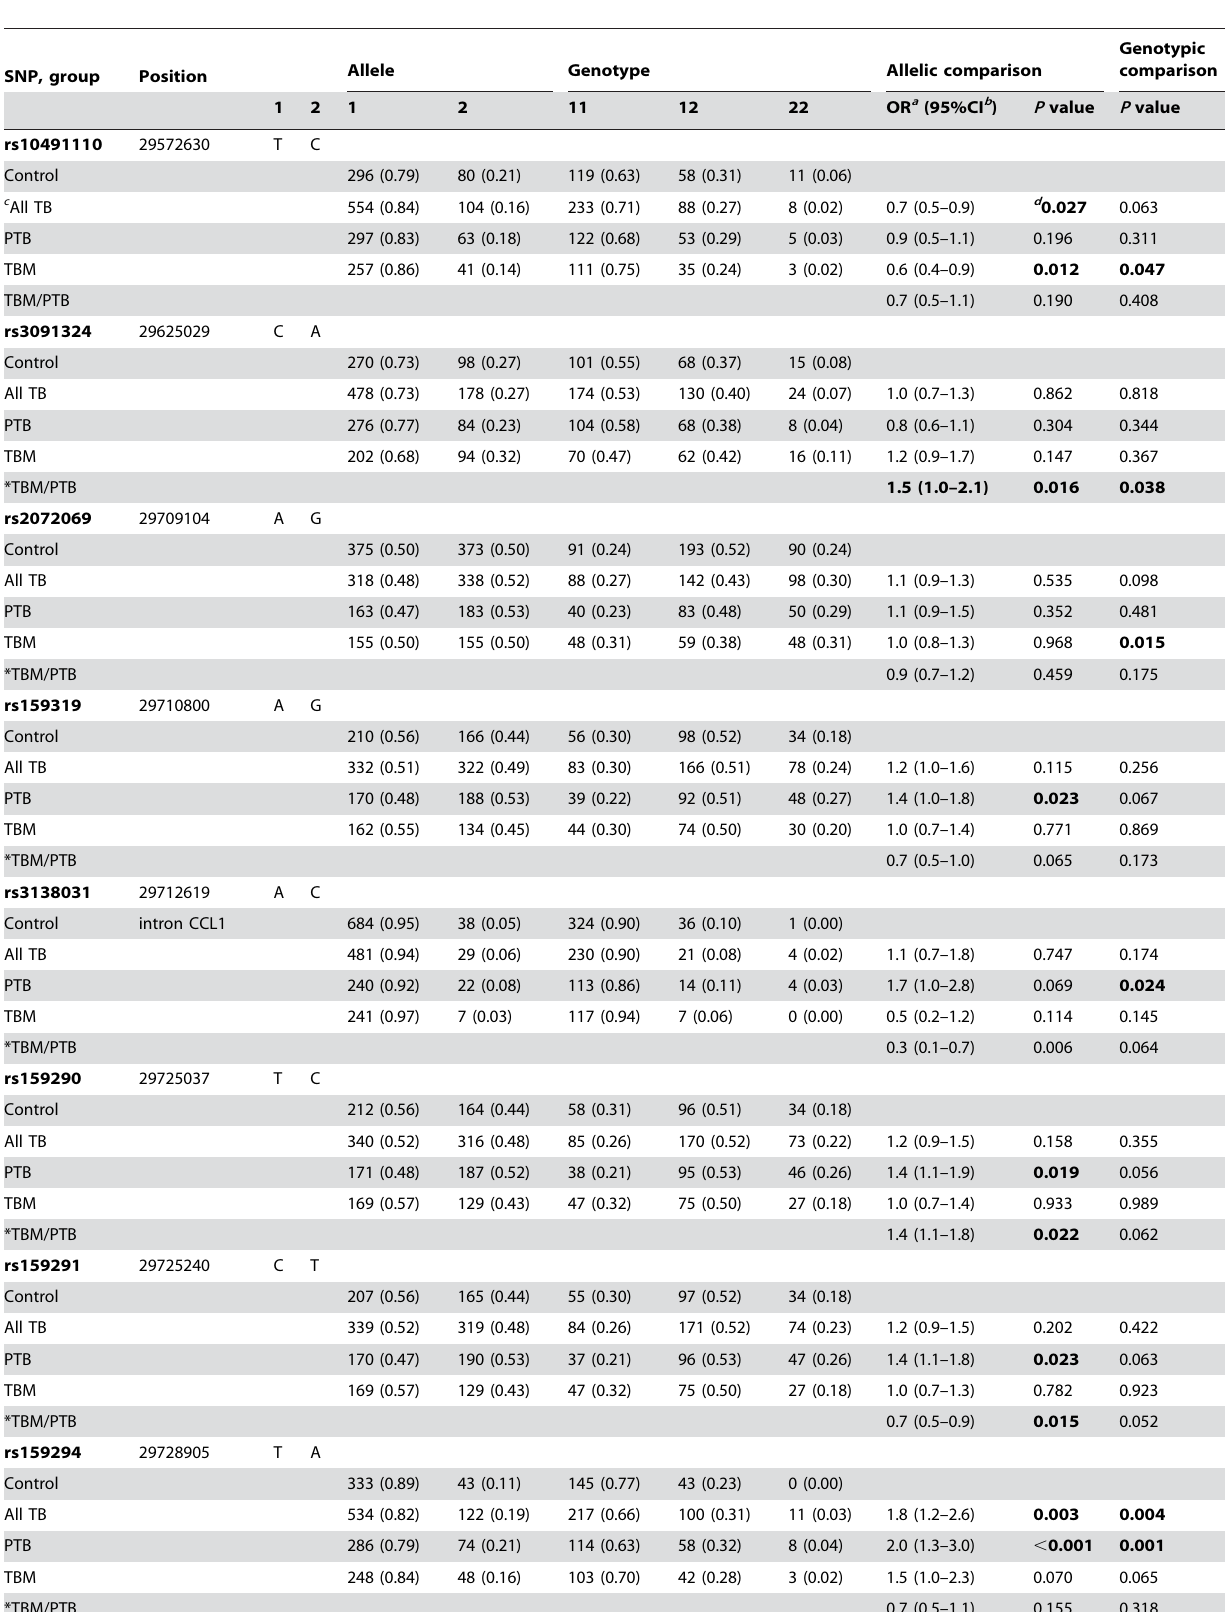
Table 5. CCL1 SNP allele and genotype frequencies in control and TB